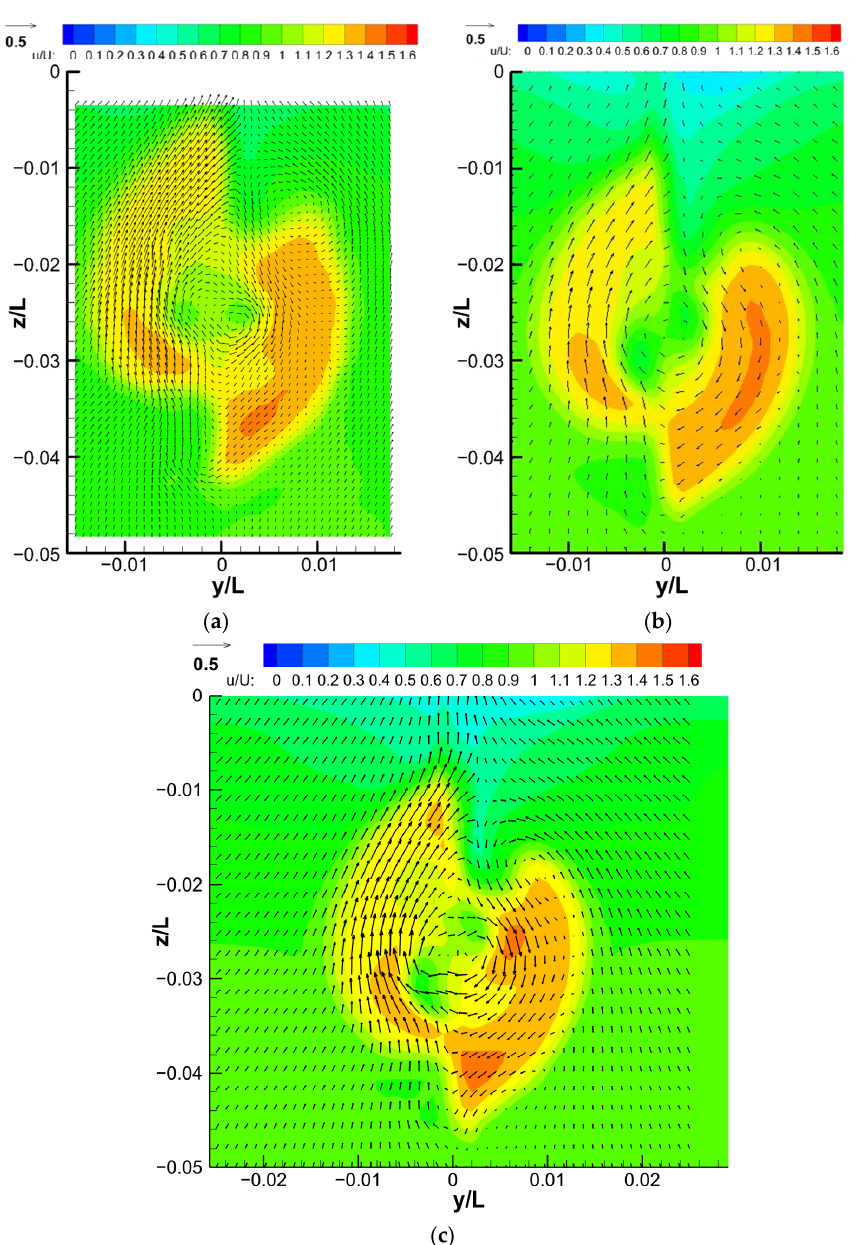
Figure 17. Propeller wake field after rudder ( x/L = 1.025): ( a )